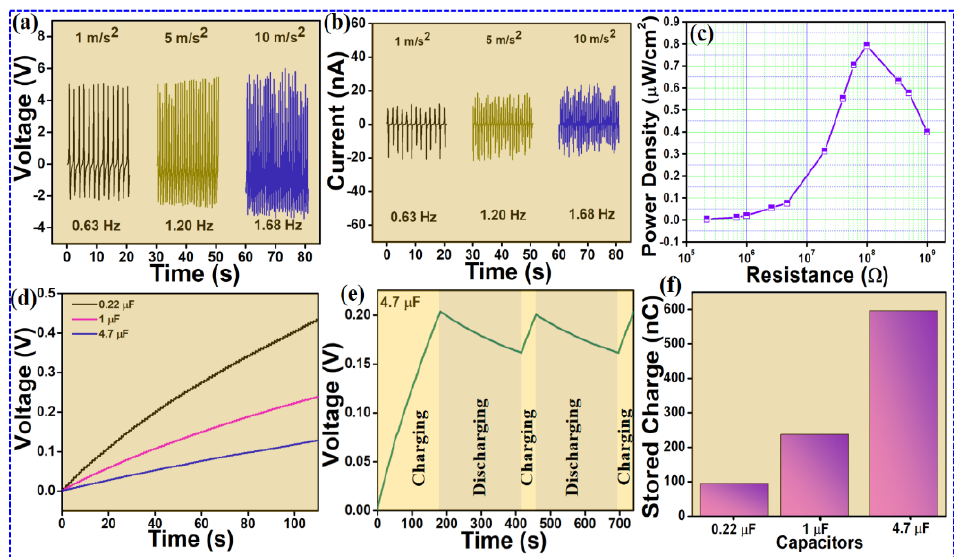
Figure 4. Electrical response of the piezoelectric nanogenerator. ( a , b ) Voltage and current measurement of the PNG10 device at various accelerations/frequencies, ( c ) the instantaneous output power density as a function of different external load resistance, ( d ) charging curve of two capacitors with different capacitances, ( e ) charging and discharging curve of the 4.7 µF capacitors showing stable output from the device, ( f ) the amount of stored charge in the different capacitors.